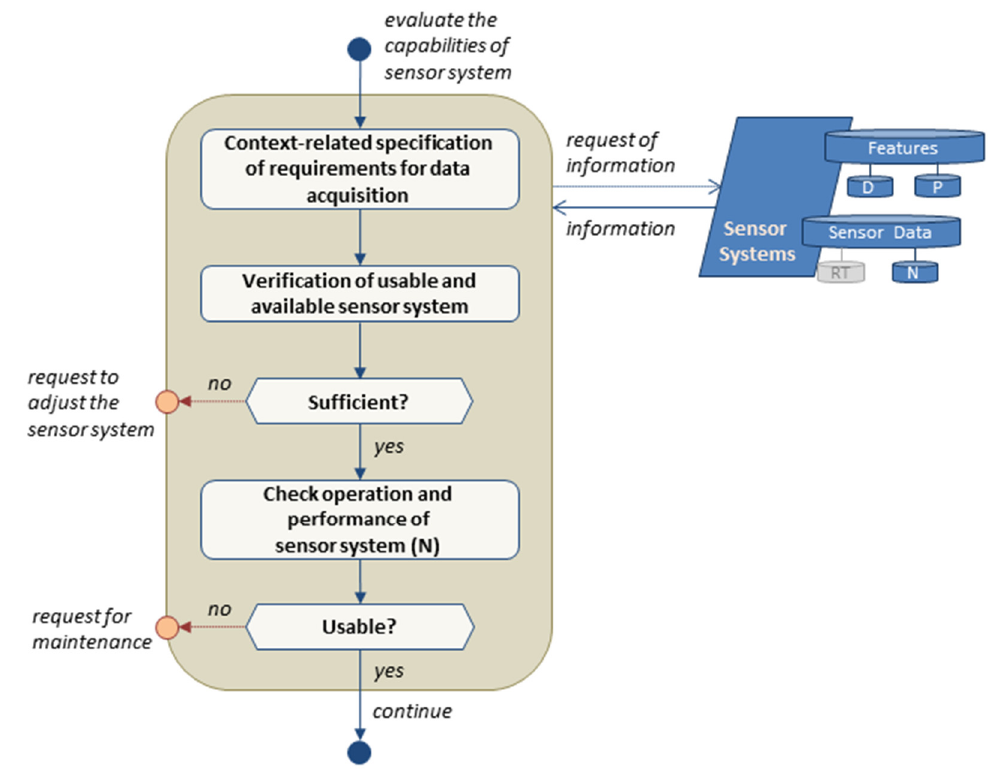
Figure 6. Flow chart of sensor system evaluation as a function of context specification.